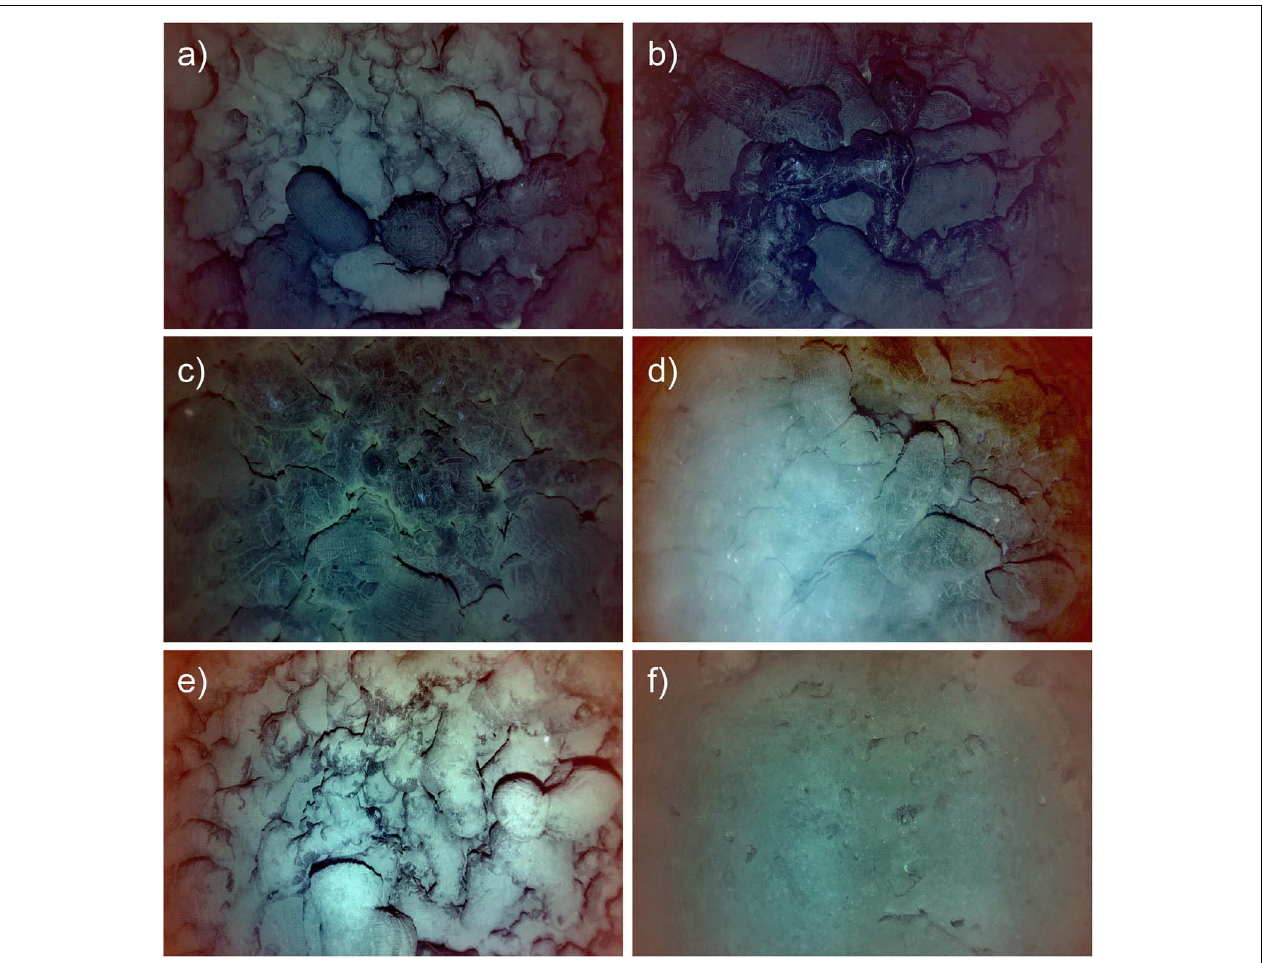
FIGURE 5 | Images from AUV Sentry dive 367 photo survey on 03 December 2015 showing young lava flow, evidence of hydrothermal venting, and surrounding older seafloor. Horizontal dimension of photos is ∼ 5 m. See Figure 4B for photo locations. Numbers in parentheses are time of photo in GMT. (a) Contact between young and old lava (07:33:20), (b) glassy young pillow lava (07:03:43), (c) hydrothermal sediment on young flow (07:04:43), (d) milky hydrothermal venting from young flow (07:05:53), (e) surrounding older lava (09:42:10), (f) older seafloor at east edge of survey with almost complete sediment cover